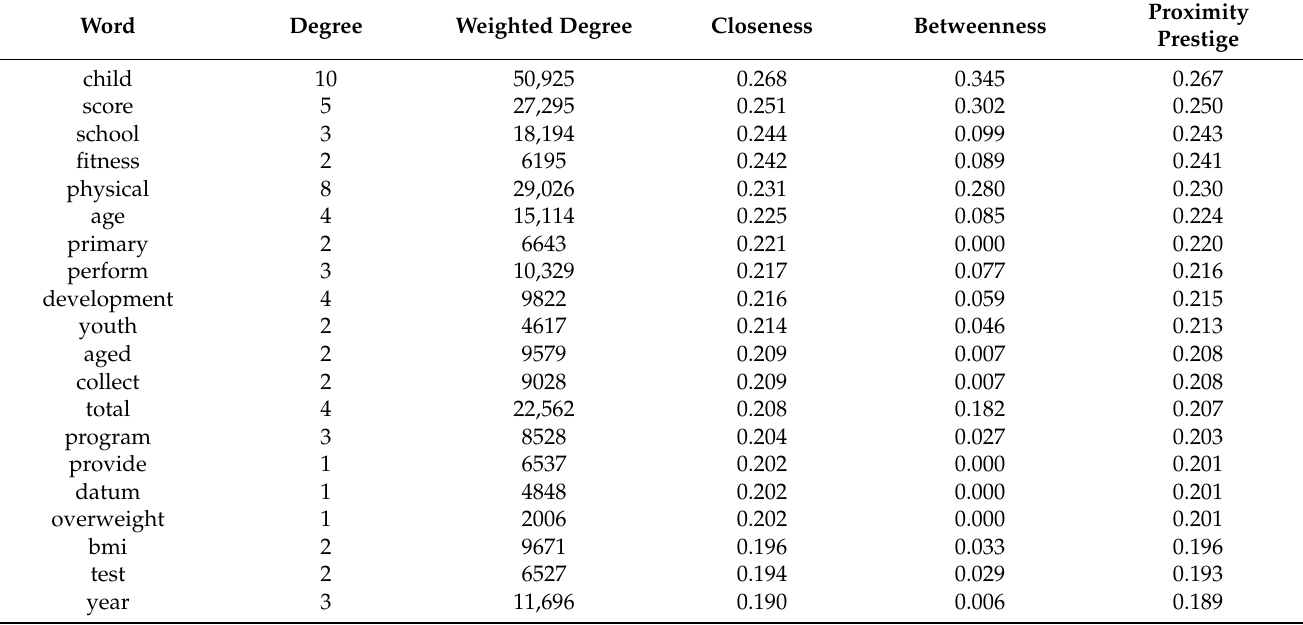
Table 2. Centrality values of the 20 most prestigious words in the co-occurrence